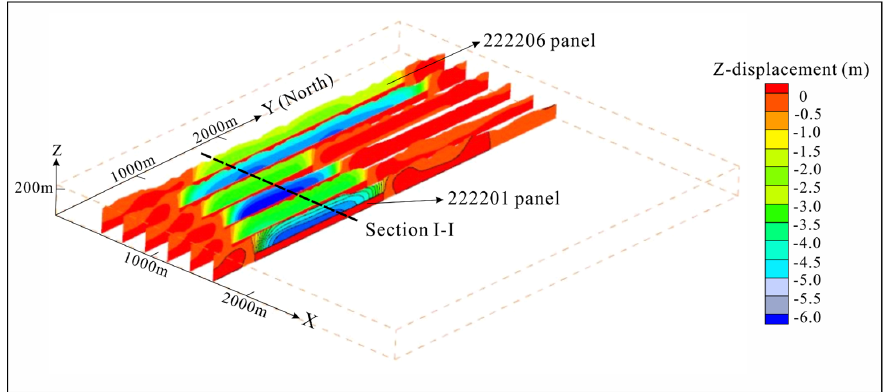
Figure 10. The longitudinal section (along the mining direction) of the S 1 contour of 6 panels.